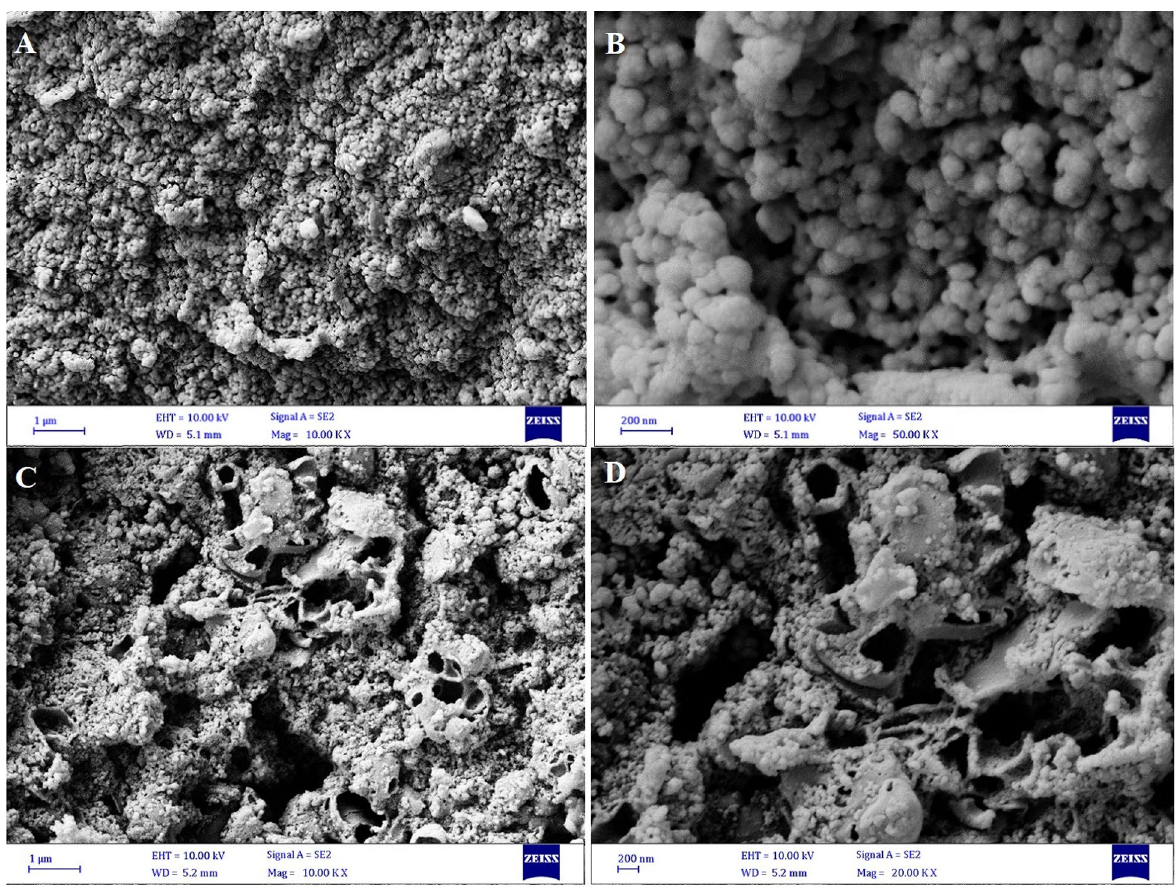
Figure 3. FT-IR spectra of P(2-AT) ( A , B ) and (N, S)-MPC (C, D